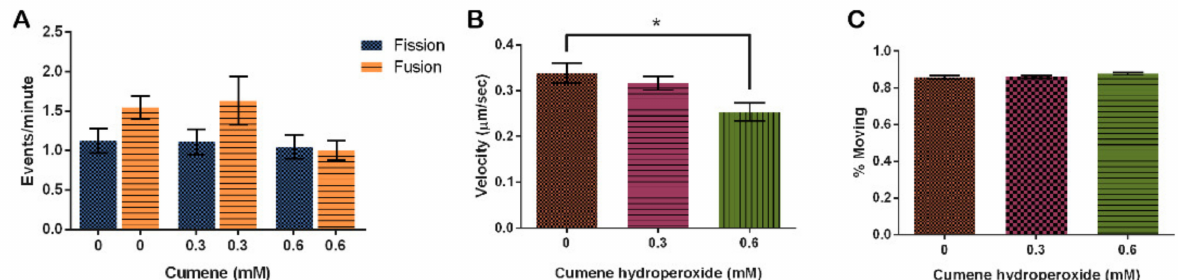
Figure 4. Effect of cumene hydroperoxide on mitochondrial dynamics. ( A ) Fusion trends faster in vehicle control and 0.3 mM cumene, but cumene does not significantly alter fission and fusion (n = 30 cells, p = 0 .0896). ( B ) Cumene significantly decreases mitochondrial velocity but ( C ) has no effect on the number of mitochondria moving (n = 30 cells, p = 0.0062 and 0.1669, respectively). Columns are averages, error bars represent the standard error and * indicates significance.